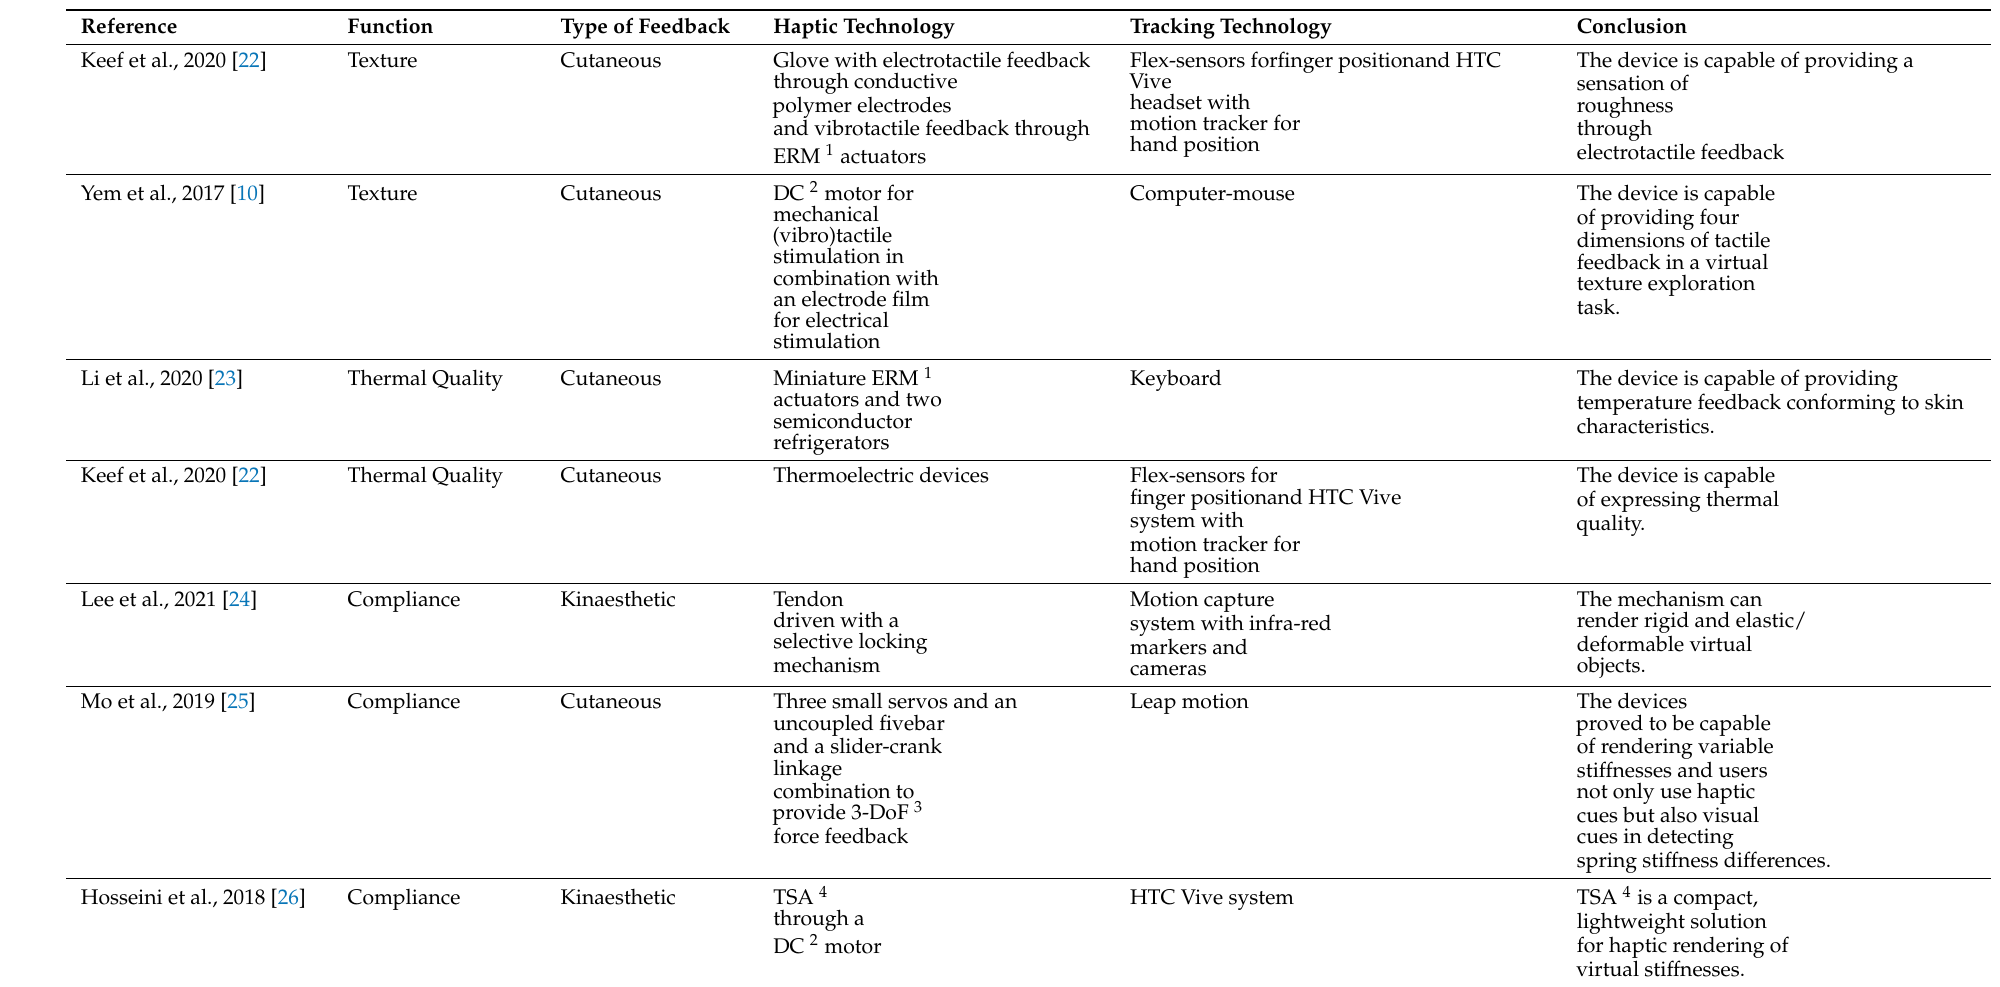
Table 1. Overview of haptic wearable devices tested on virtual object property